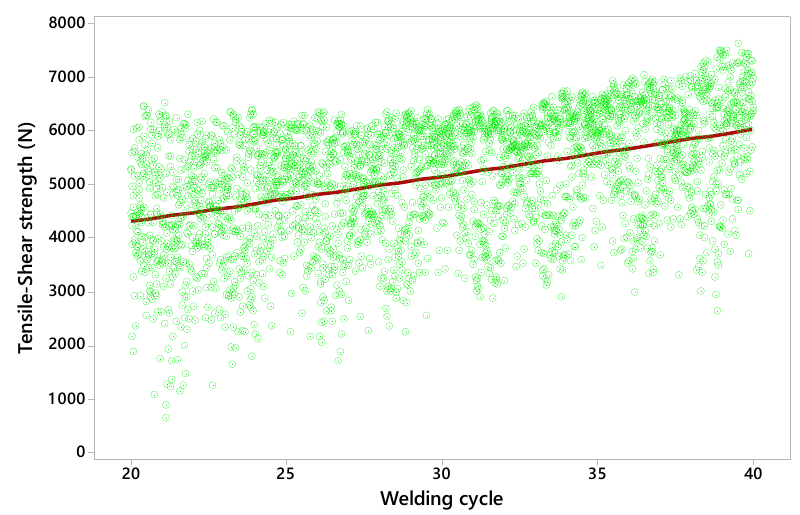
Figure 13. Effect of welding cycle on TSS of spot welds.